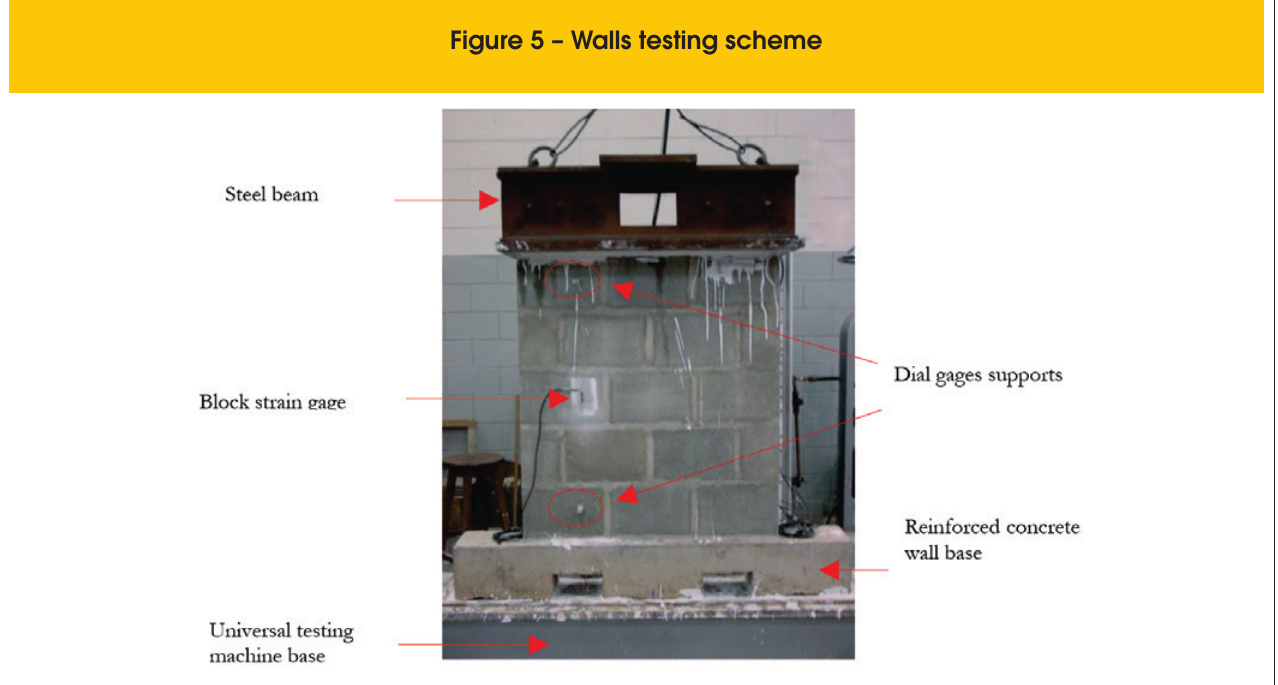
Figure 5 – Walls testing